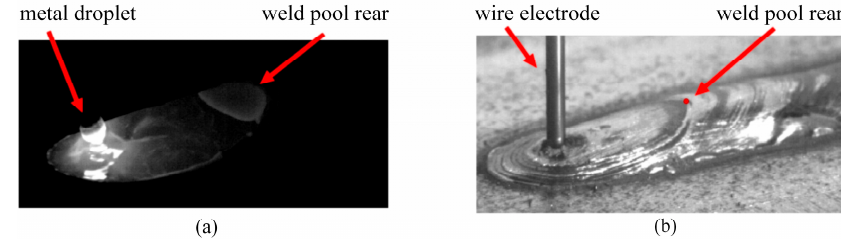
Figure 3. Reference points and objects in the image: ( a ) Typical frame acquired with the actual image acquisition system; ( b ) Off-line frame illustrating the weld pool rear and the corresponding reference point in the weld bead.